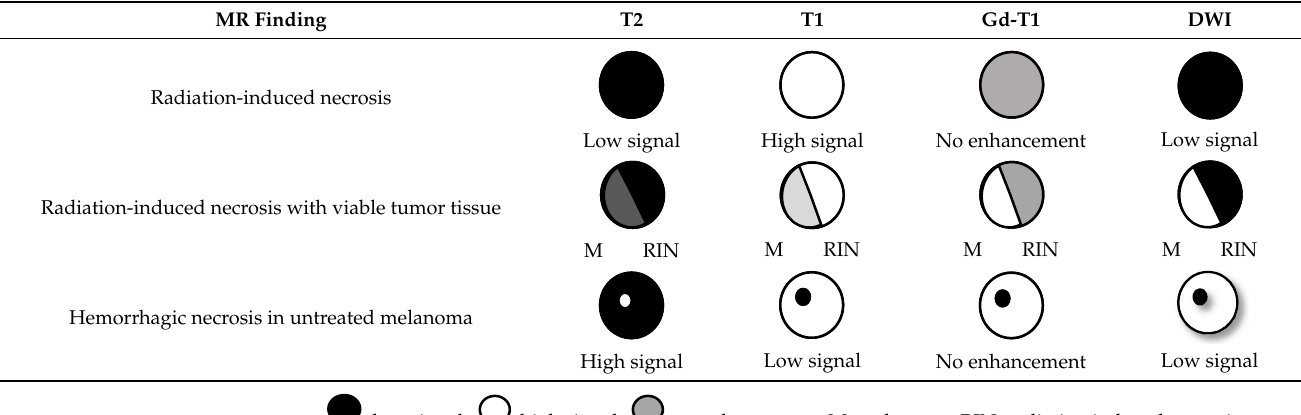
Table 6. Chart summarizing the MR imaging patterns of necrosis.